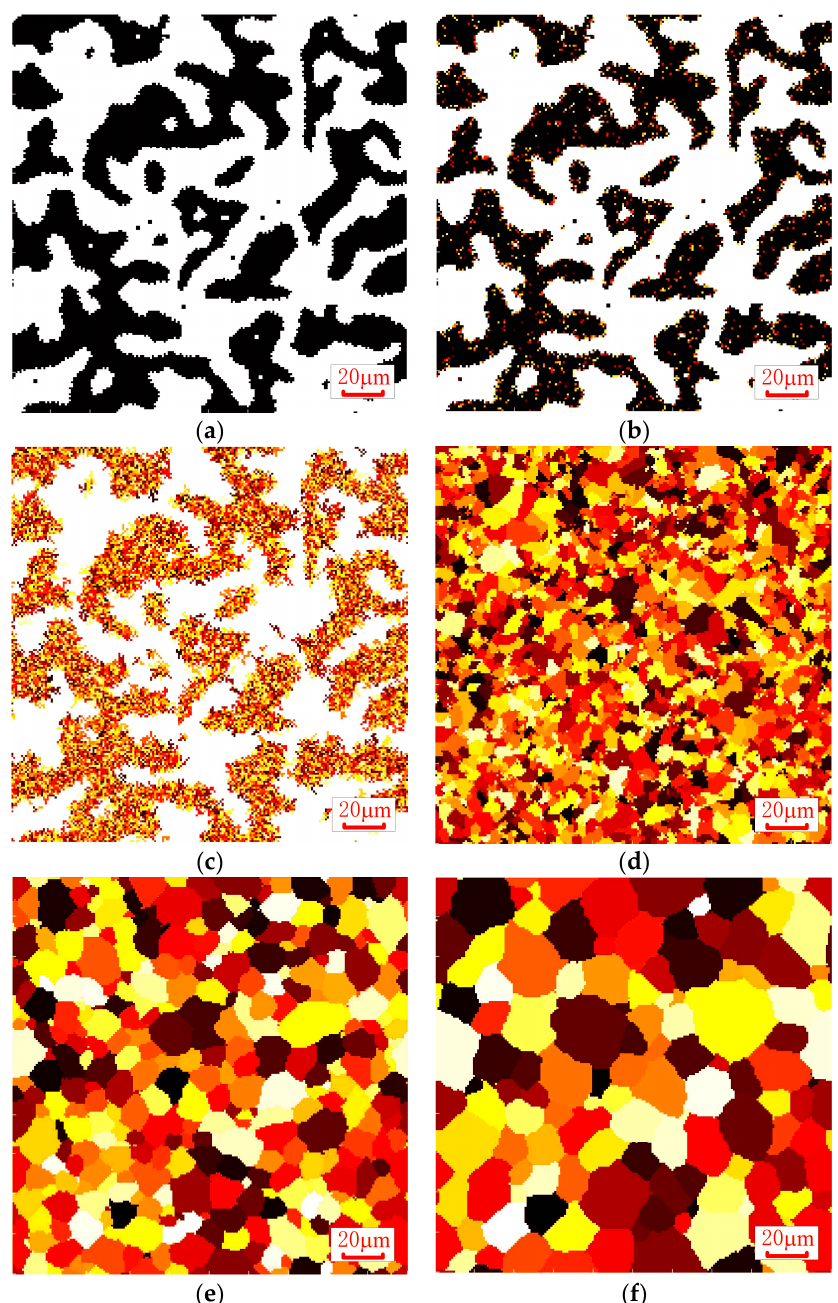
Figure 6. Austenite transformation at different times. ( a ) t = 0 s; ( b ) t = 0.3519 s; ( c ) t = 0.35216 s; ( d ) t = 0.35232 s; ( e ) t = 0.35612 s; ( f ) t = 0.36647 s. ( a )–( c ) white represents ferrite; black represents pearlite; other colors represent austenite grains with different crystallographic orientations; ( d )–( f ) Different colors represent austenite grains with different crystallographic orientations.